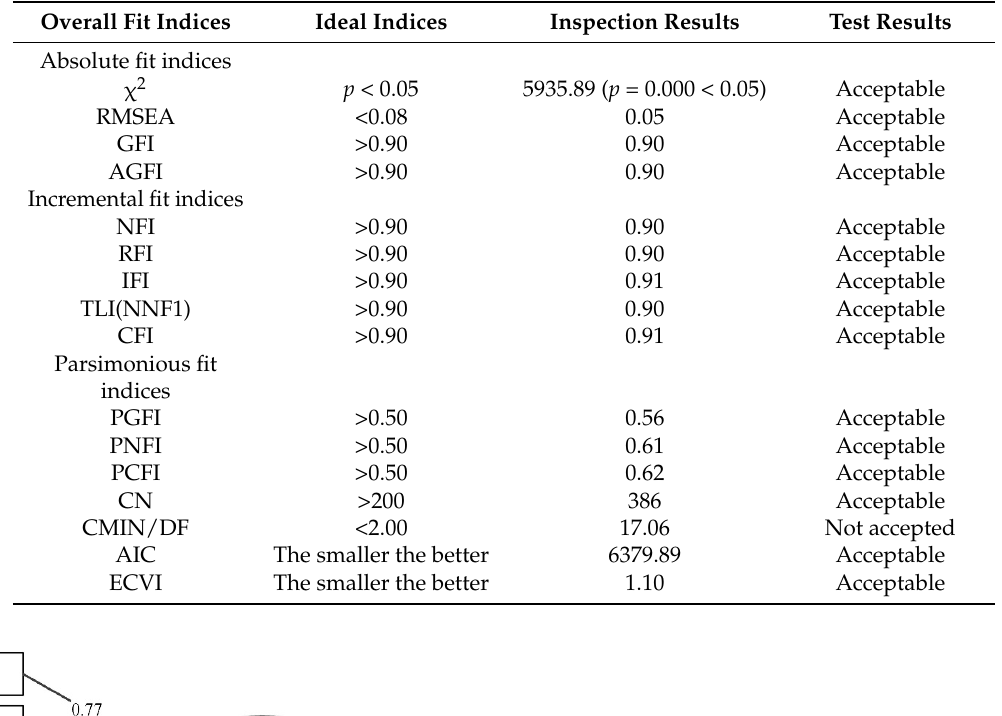
Table 7. Summary of the goodness-of-fit indices for the structural residuals model in multi-group comparisons of SEMs.